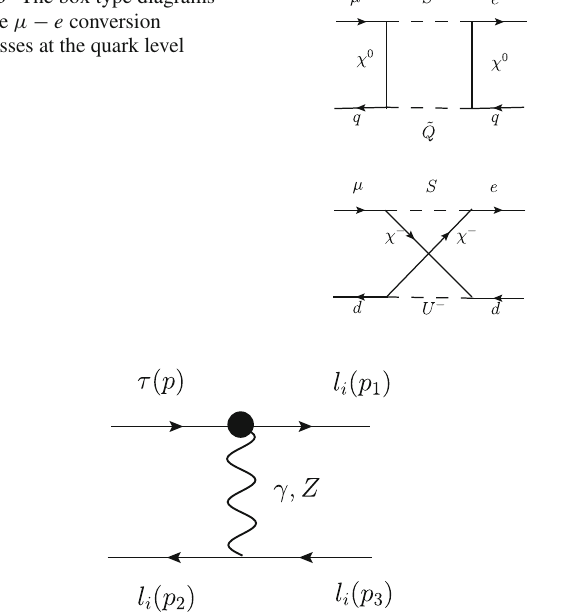
Fig. 3 The box type diagrams for the μ − e conversion processes at the quark level